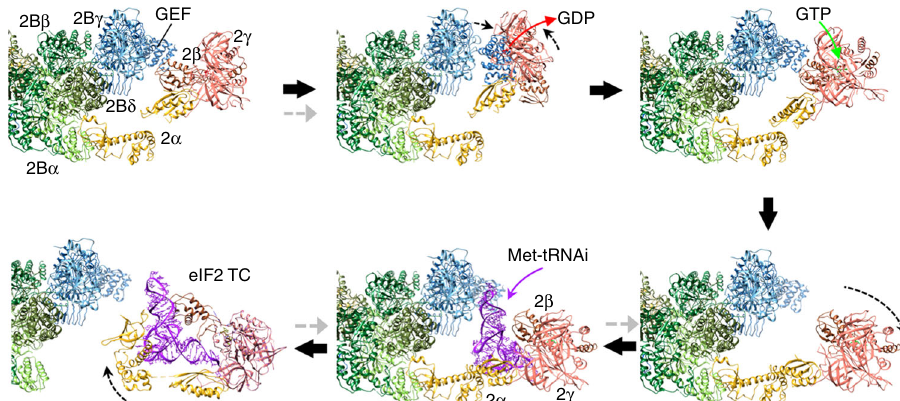
Fig. 6 Model for eIF2B GDP exchange and ternary complex (TC) formation. A series of steps for guanine nucleotide exchange factor (GEF) action and recruitment of initiator tRNA to form TC based on our structures and docking of the GEF domain (PDB 1PAQ), GDP (PDB 4RD6) or initiator tRNA (3JAP, chain 1), as outlined in the main text and Supplementary Movie 2. Grey arrows indicate steps affected by eIF2(